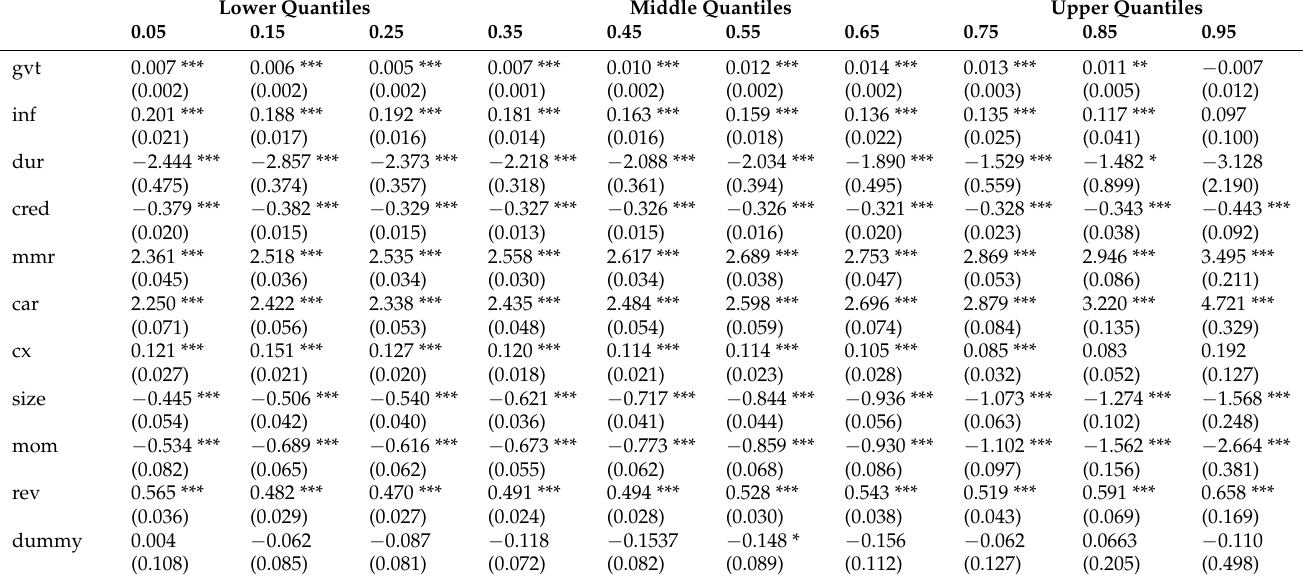
Table 2. Panel Conditional Quantile Regression—Government Response